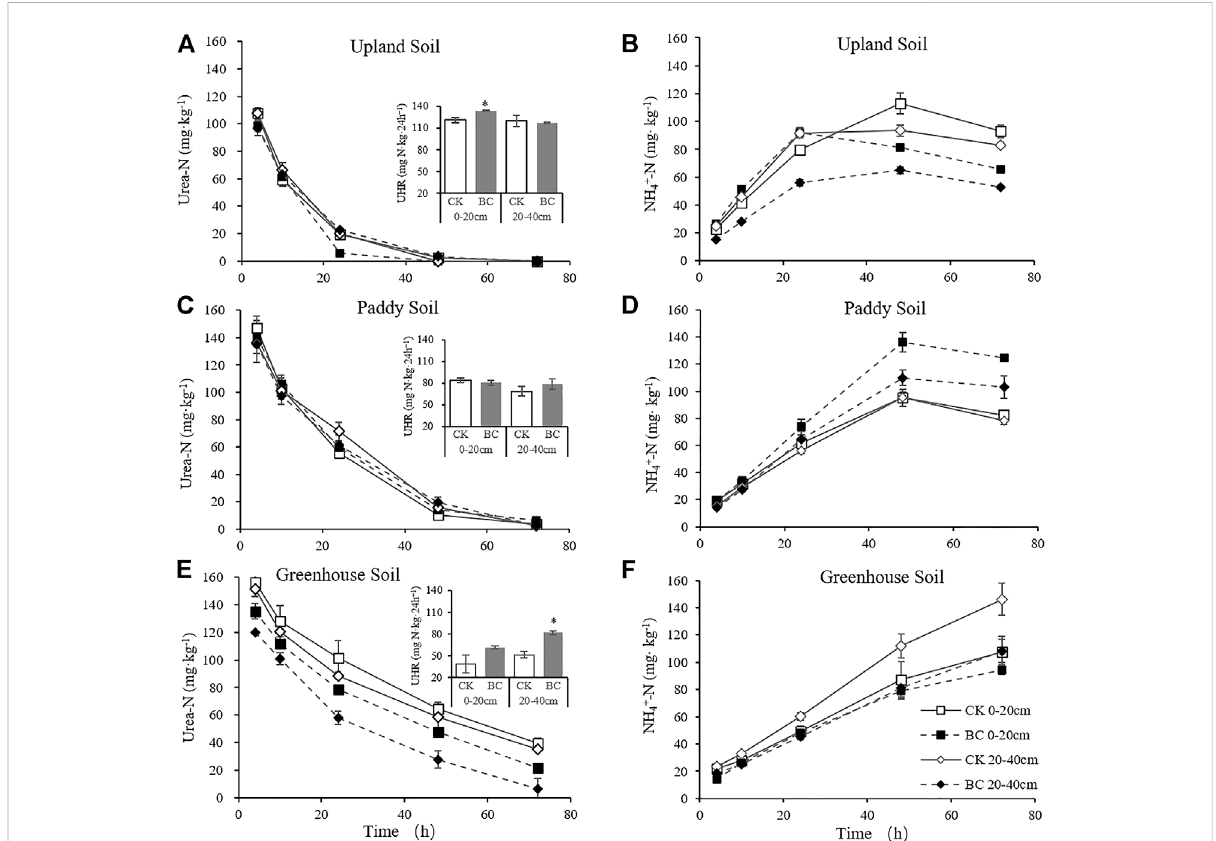
FIGURE 3 Dynamic ofUrea-Nand NH 4 + -N concentrationduring 72 hofincubationafter 140 mg kg − 1 urea-N addition. Uplandsoil (A,B) ;paddy soil (C,D) ; greenhousesoil (E,F) . Barsrepresent thestandarderror ofthemean.Columncharts inA,C and Erepresent urea hydrolysis rate,*indicate signi fi cant difference between BC and CK within same soil layer at p <